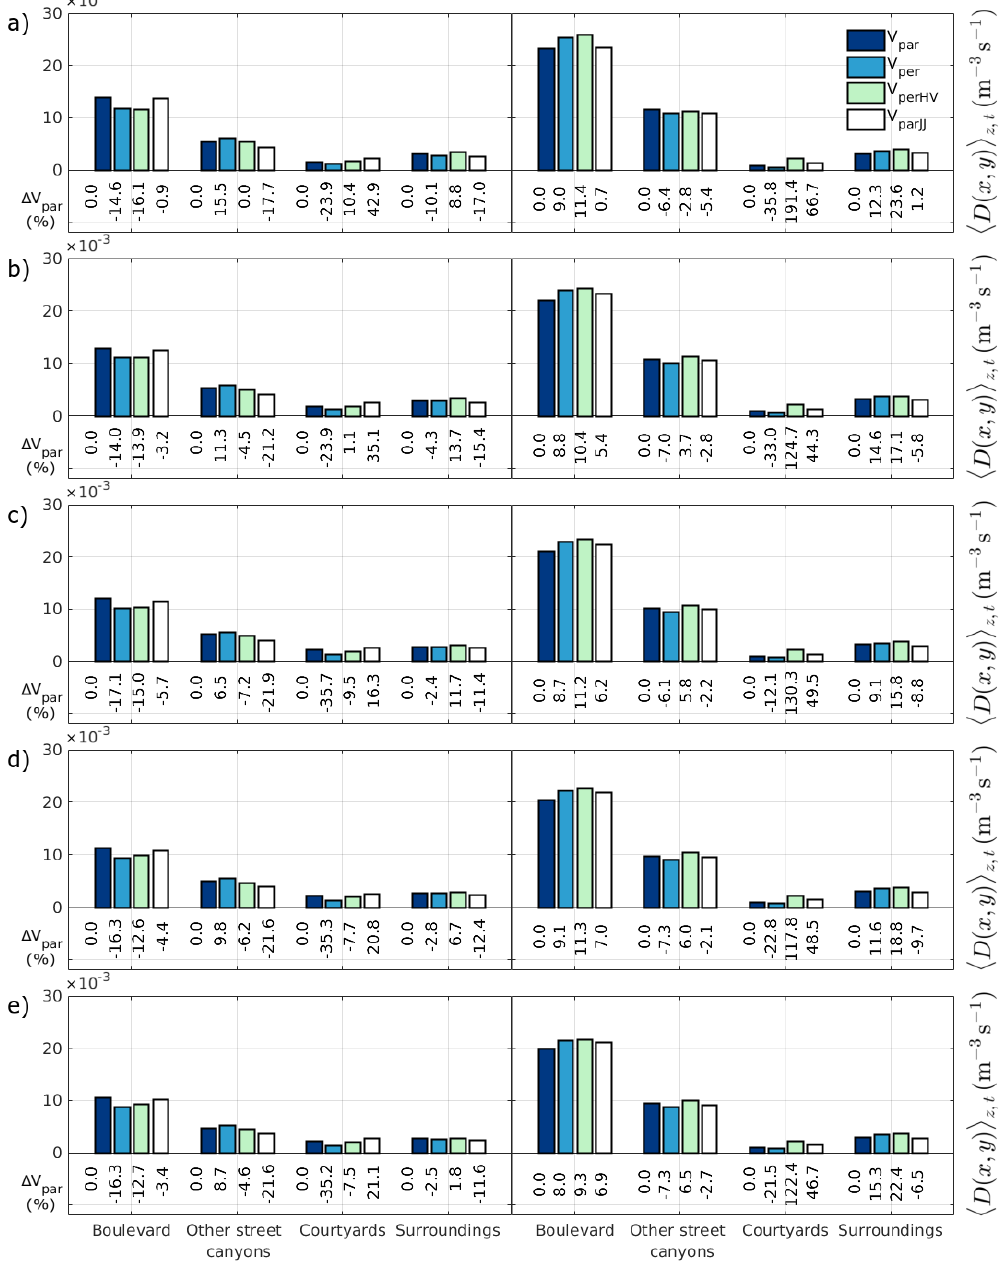
Figure A5. Mean (cid:104) D ( x , y ) (cid:105) t , z ( × 10 − 3 m − 3 s − 1 ) under the general ( left ) and wintry ( right ) inflow conditions separately for the boulevard, other street canyons, courtyards and surroundings between z = 1–20 m for all runs. D is calculated for different averaging periods: ( a ) 30 s; ( b ) 40 s; ( c ) 50 s; ( d ) 60 s and ( e ) 70 s. The difference to the value in V par is given in percentages ( ∆ V par